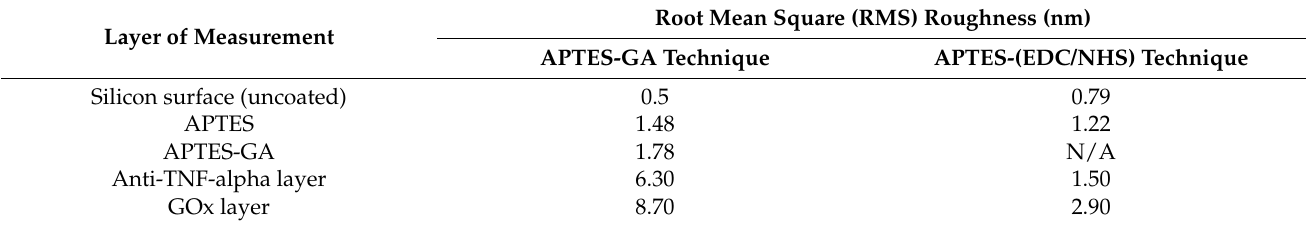
Figure 9. Thickness of the layers after each stage of GOx coating using APTES-GA technique and APTES-(EDC/NHS) technique. Table 2. Root mean square (RMS) roughness of each coated layer by AFM